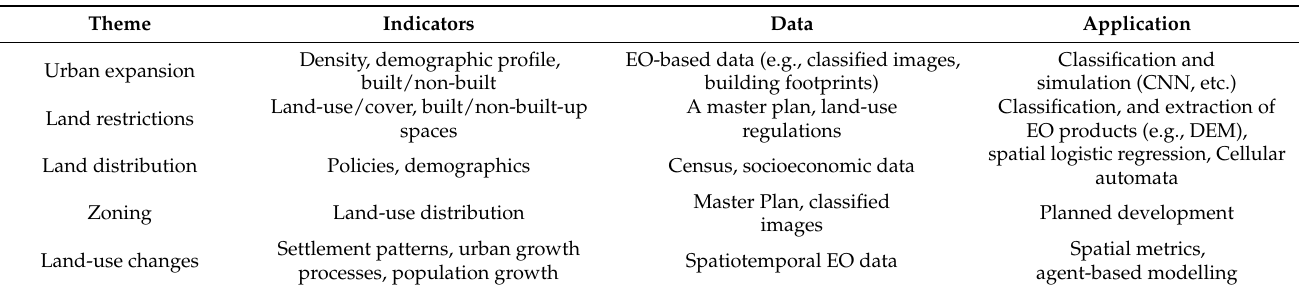
Table 2. Land use planning indicators with measurements, data required and applications (adapted by [11]).